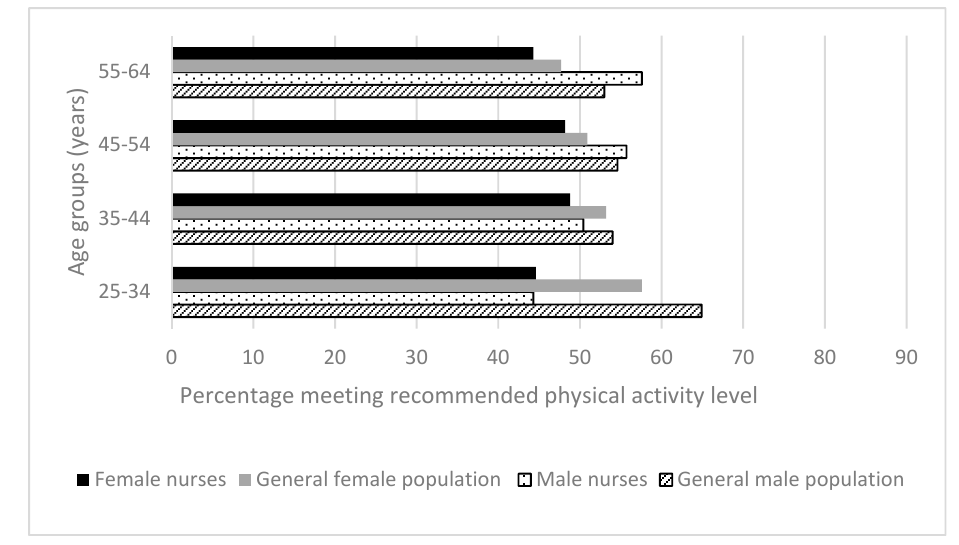
Figure 3. Health-related behaviors of nurses and midwives compared to the Australian general population 2014–2015 [29]: Physical activity.